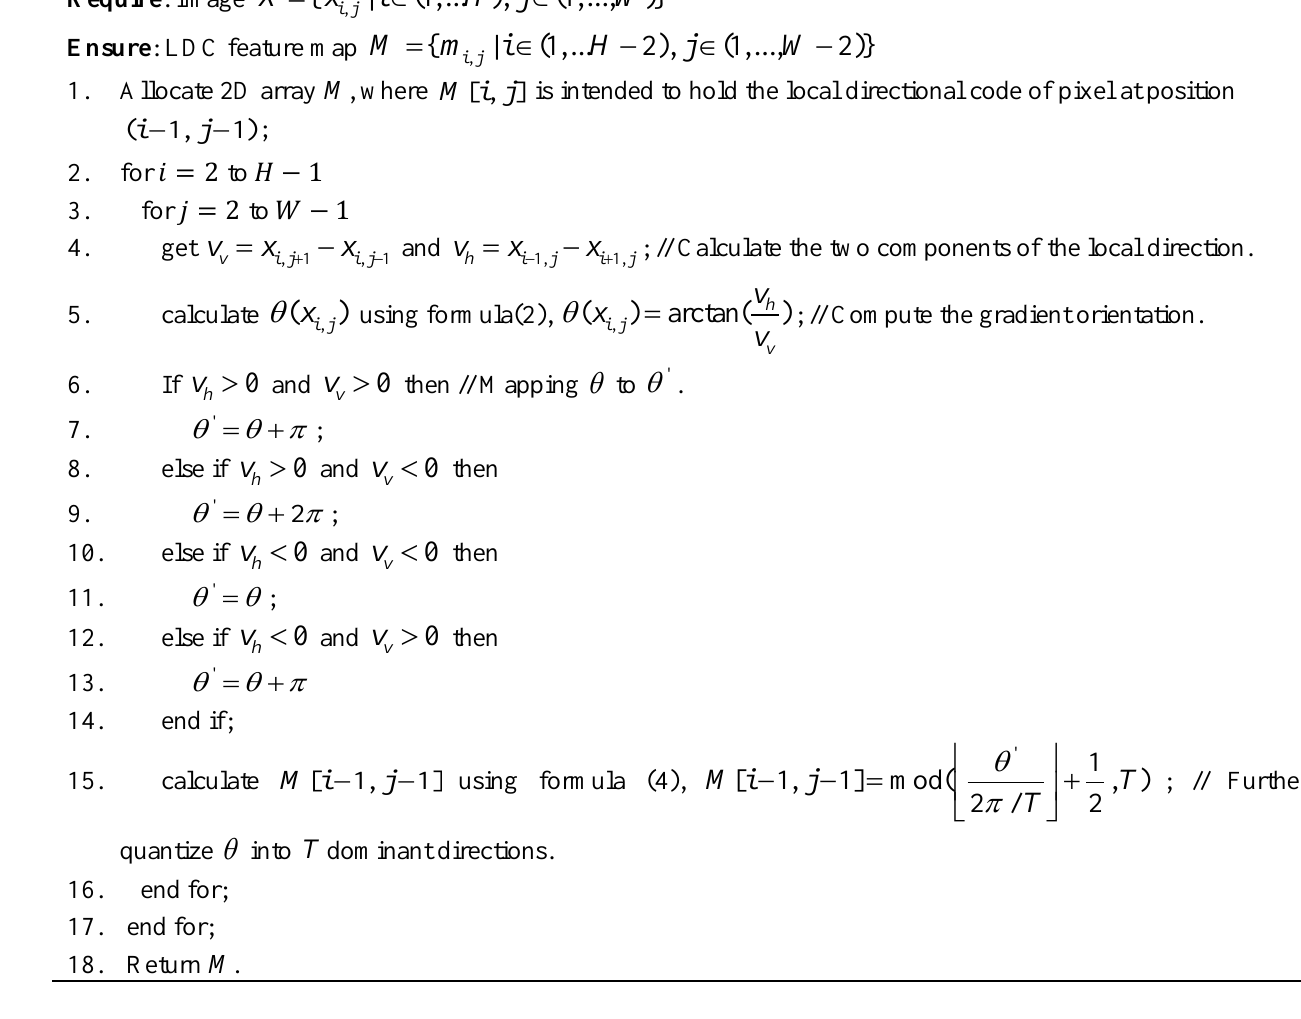
Algorithm 1. The LDC feature